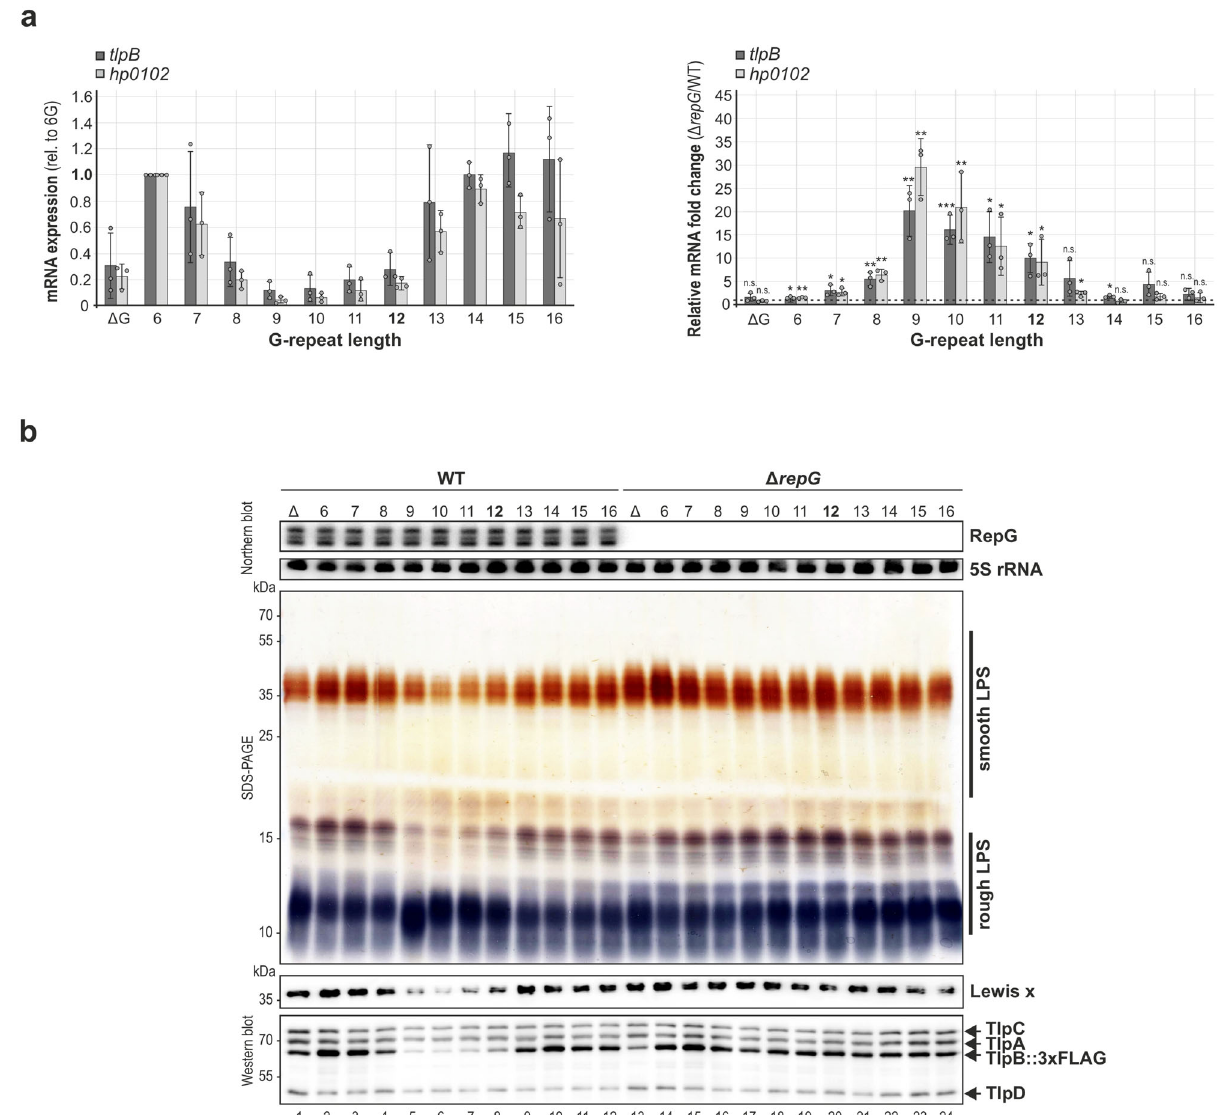
Fig. 5 The G-repeat length impacts RepG-mediated tlpB - hp0102 co-regulation and in turn smooth LPS production. a (Left panel) RT-qPCR of relative tlpB and hp0102 mRNA levels of different tlpB leader mutants ( Δ G, 6 – 16G) in the H. pylori 26695 wild-type background. The mRNA level of each gene in the tlpB 6G-leader mutant was used as reference and set to 1. (Right panel) Relative fold changes of tlpB and hp0102 mRNA levels upon repG deletion in H. pylori 26695 tlpB leader mutants when compared to the respective wild-type backgrounds. The fold changes are shown as mean of three biological replicates with corresponding error bars (s.d.). *** — highly signi fi cant, p -value < 0.001; ** — very signi fi cant, p -value < 0.01; * — signi fi cant, p -value < 0.05; n.s. — not signi fi cant; Student ’ s t -test, two-tailed. b The LPS patterns and Lewis x antigen levels of tlpB leader mutants in H. pylori 26695 wild-type and Δ repG mutant backgrounds were analyzed by silver staining and western blot analysis with anti-Lewis x antigen antibody, respectively. Expression of the chemotaxis receptors was analyzed by an anti-TlpA22 antiserum. Note that tlpB leader mutants express FLAG-tagged TlpB 21 . A representative silver-stained PAA-gel and western blot are shown (out of three independent experiments). Source data underlying ( a , b ) are provided as a Source data fi